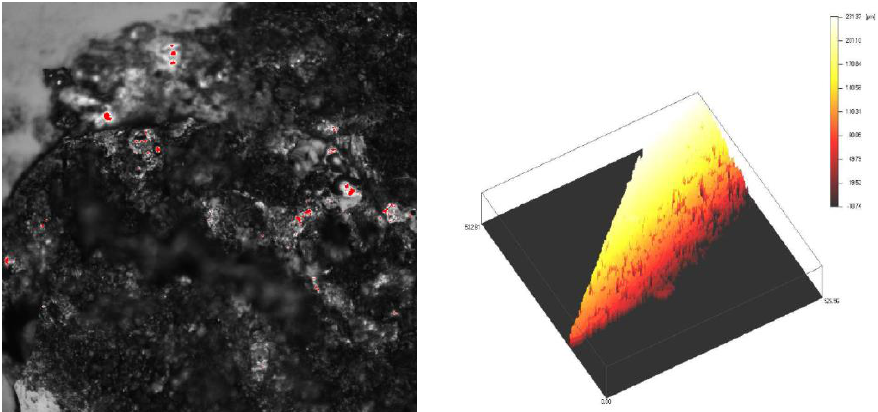
Figure 4. The nano-focus image of the carbon strand surface (left) and random illustration of the carbon nanoparticle (CNP) strand surface. The right image shows the position of points –10 to 231 micrometers apart on the surface.